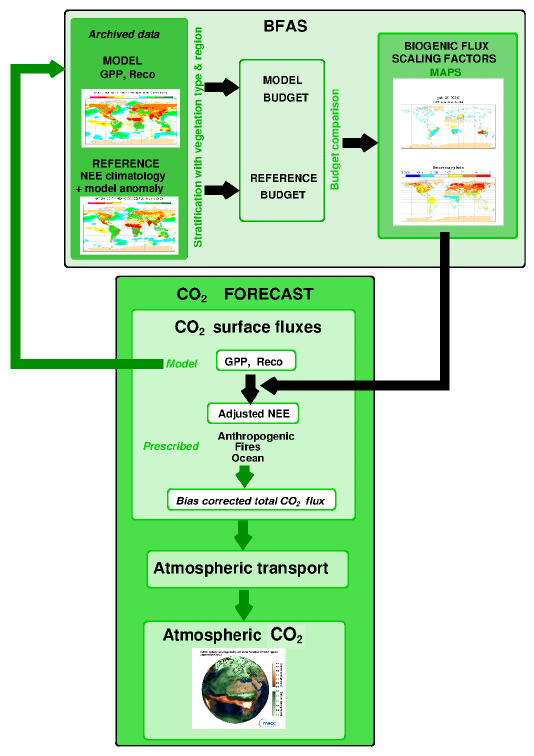
Figure 1. Schematic showing how BFAS fits in the atmospheric CO 2 forecasting system. BFAS is called before each forecast to compute the scaling factors for the model NEE (i.e. GPP + R eco ) based on the past archived forecasts. The maps of the scaling fac- tors are then passed to the model which applies the adjustment to the output biogenic CO 2 fluxes from the land surface model. After combining the adjusted NEE fields with the other prescribed CO 2 fluxes, the resulting bias corrected fluxes are passed to the transport model to produce the atmospheric CO 2 forecast.